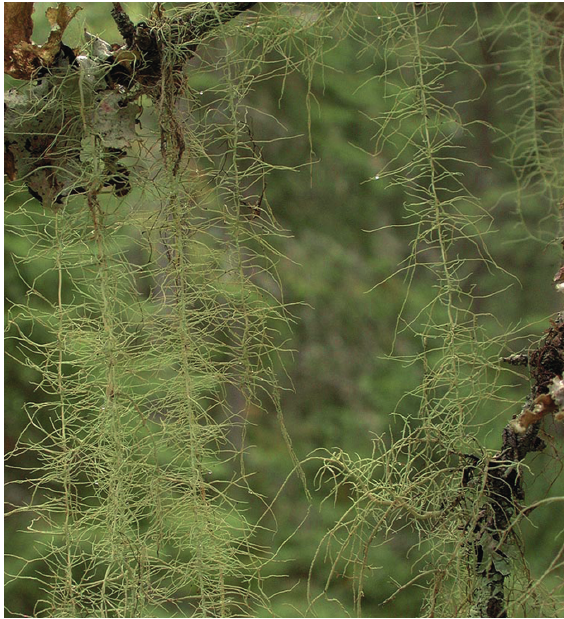
Figure 1 - U. longissima species in their natural